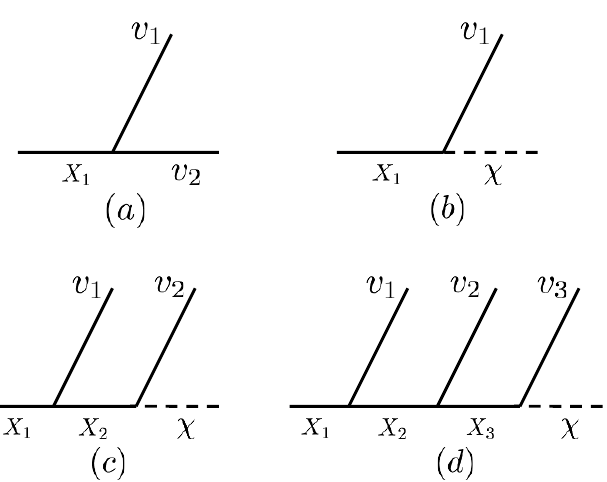
Figure 1 . Benchmark decay topologies which allow for inclusive searches for the production of a new heavy resonance X 1 . Here v 1 , v 2 and v 3 are SM particles which are reconstructed in the detector (either directly, or through their respective visible decay products), while (cid:31) is a potential dark matter candidate which is invisible in the detector. X 2 and X 3 are additional BSM particles with masses m X > m X > m X > m (cid:31) 1 2 3